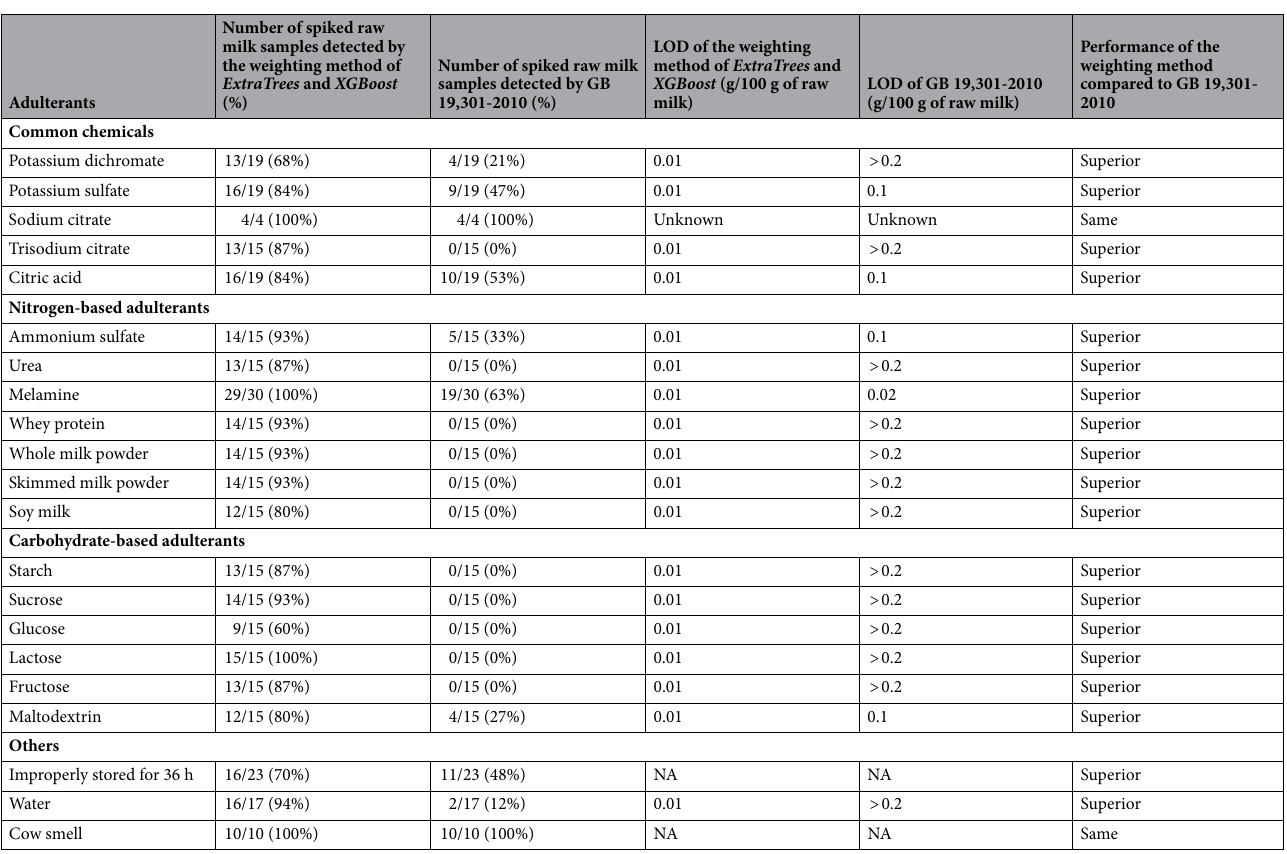
Table 4. Number of spiked raw milk samples detected by the weighting method of ExtraTrees and XGBoost and GB 19,301-2010 and the respective lower limit of detection (LOD) for each adulterant. Performance of